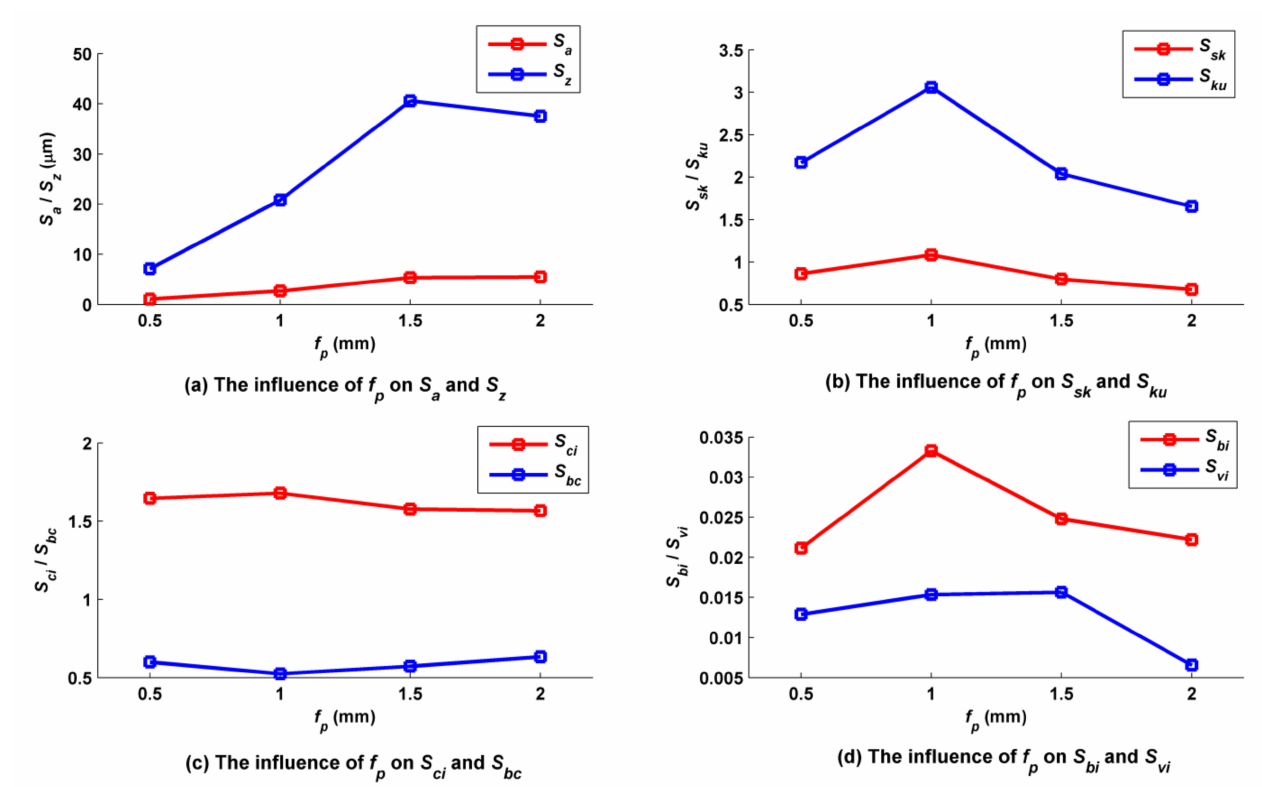
Figure 19. Influence of the leading stepover on ball-end trochoidal milling surface